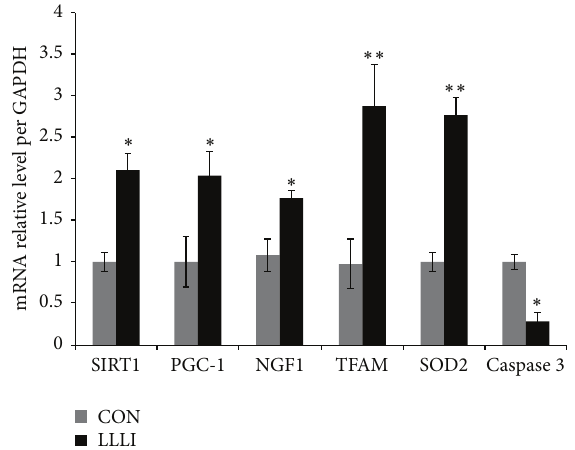
Figure 2: mRNA quantification of SIRT1/PGC-1 𝛼 axis genes in skeletal muscle subjected to 8-week LLLI. Real-time PCR is used to determine the expression of genes in gastrocnemius from the LLLI group or the CON group, relative to the endogenous control GAPDH. Values are means ± SE. 𝑛 = 10 for each group. ∗ 𝑃 < 0.05 , ∗∗ 𝑃 < 0.01 versus CON